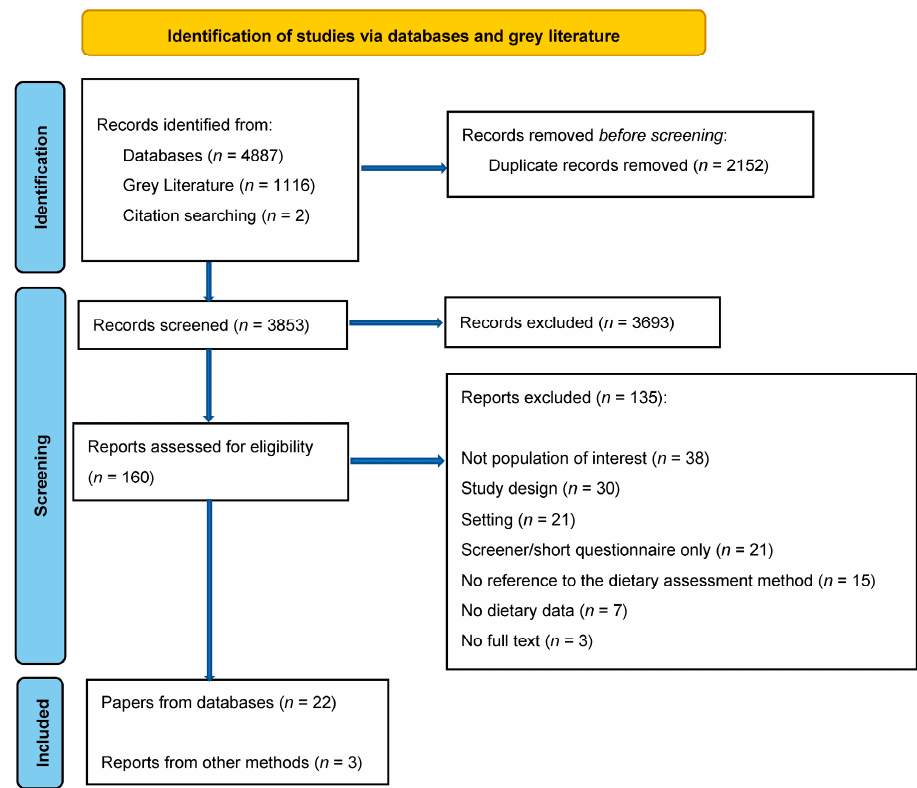
Figure 1. PRISMA flow diagram of record identification and study selection for a scoping review of the applicability of dietary assessment methods in Aboriginal and Torres Strait Islander Australians.